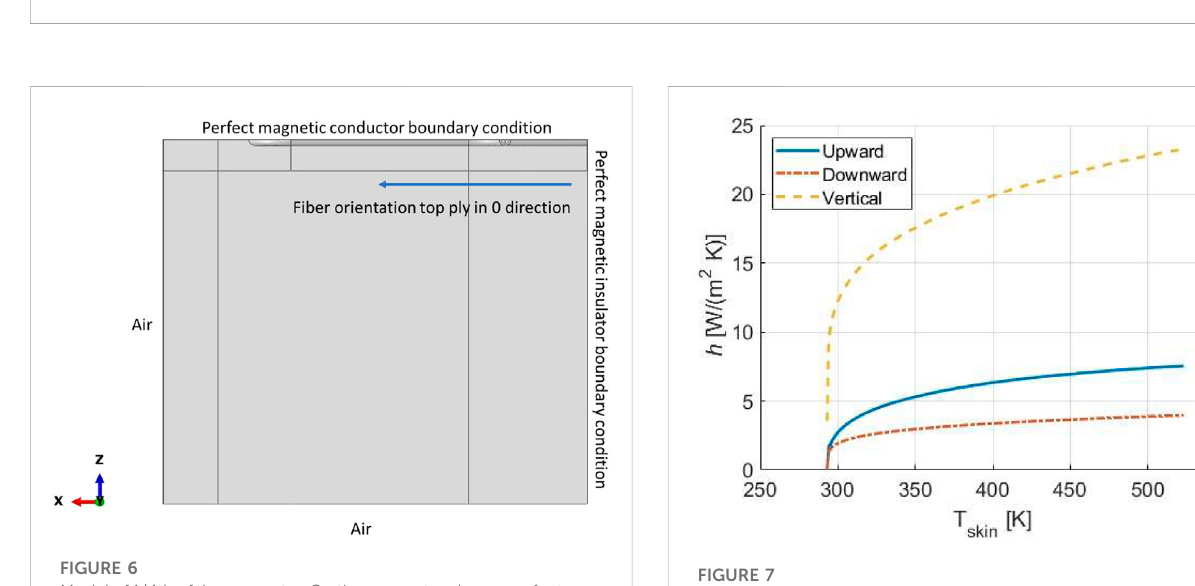
FIGURE 5 Dimensions of the coil in [mm] and position with respect to the laminate.